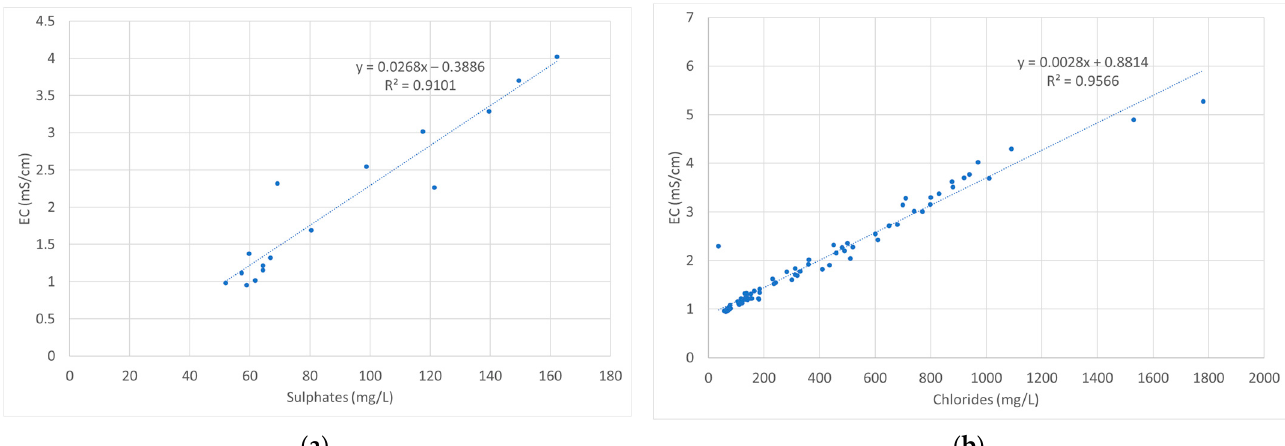
Figure 4. Correlation analysis of between: ( a ) electrical conductivity and sulfate concentration; and ( b ) electrical conductivity and chloride concentrations.